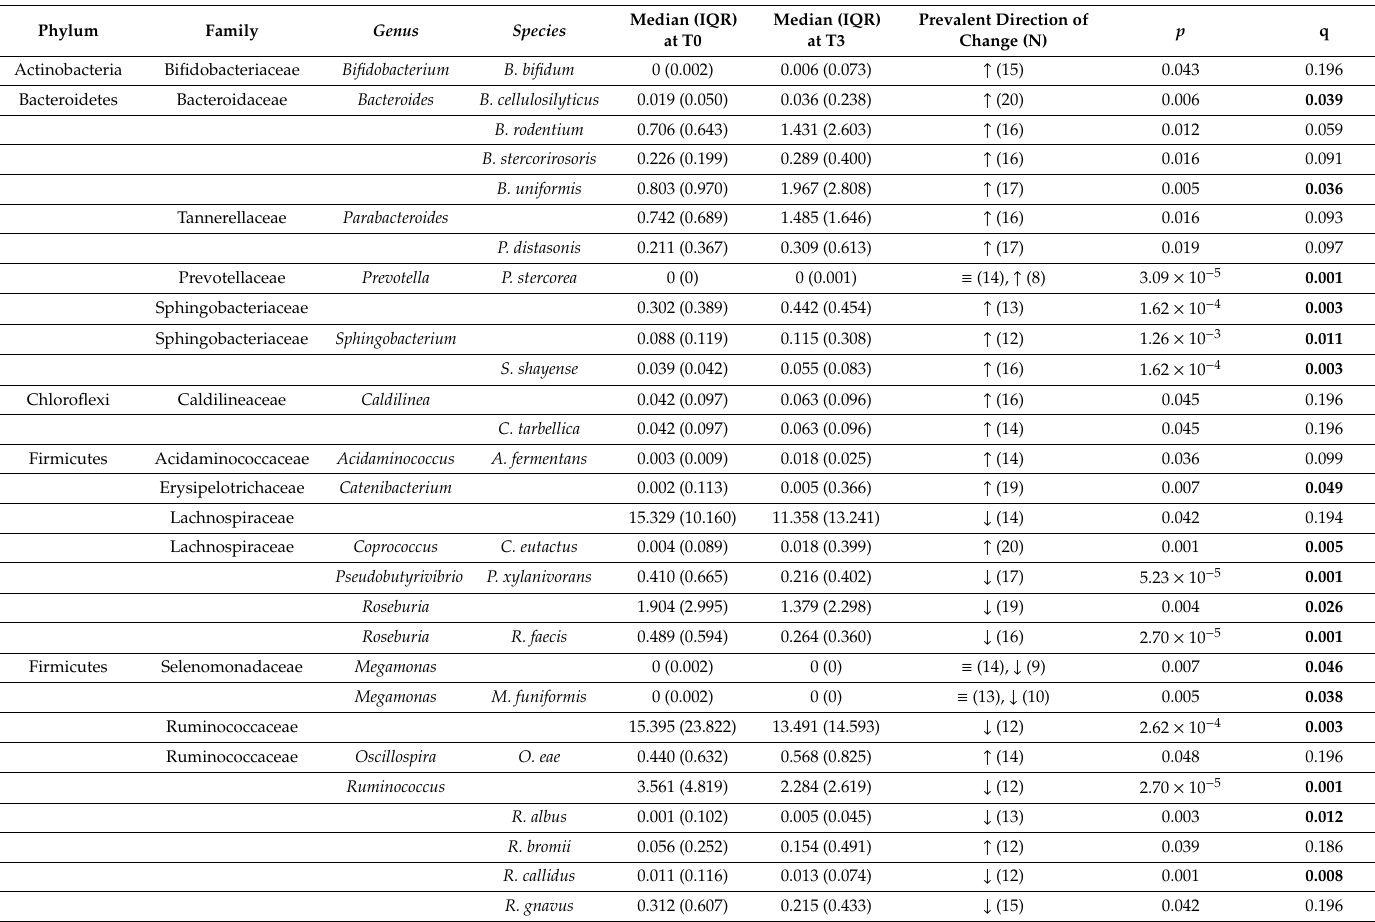
Table 3. Significant changes in the bacterial relative abundance after the nutritional intervention in overweight and obese